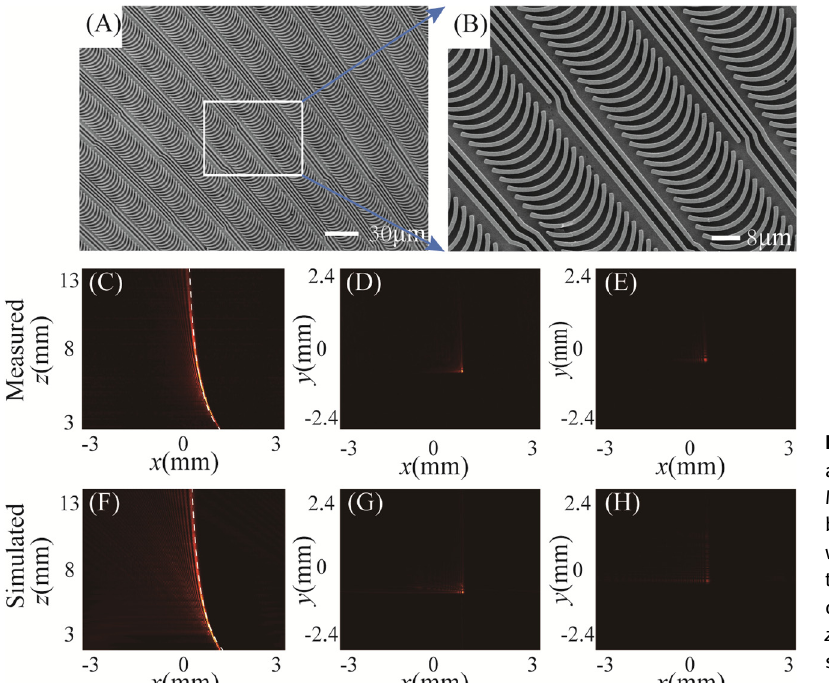
integral metasurfaces. Figure S8 depicts the measured full